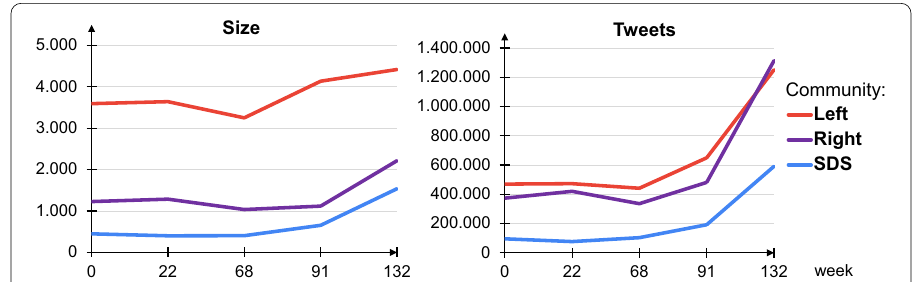
Fig. 5 Evolution of the community size and the number of tweets posted and retweeted for the three major communities: Left (red), Right (violet), and SDS (blue). The x-axis are the five timepoints at weeks t =